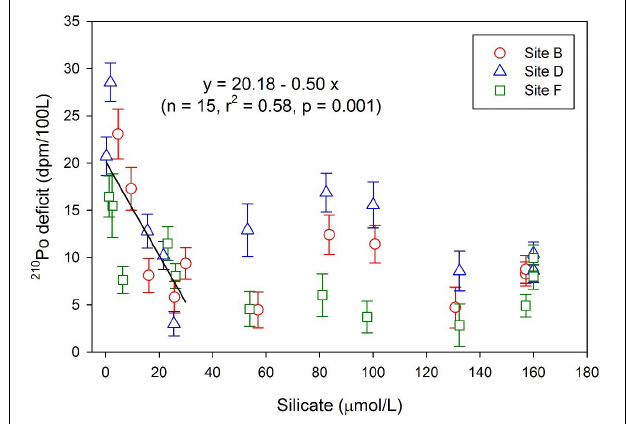
FIGURE 8 | Relationship between the 210 Po deficit and silicate in each layer at the three